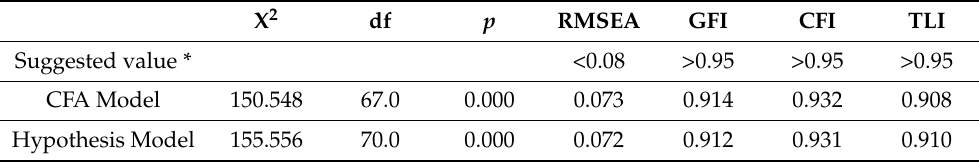
Table 5. Summary of Model Fit Indices for the Proposed Model.